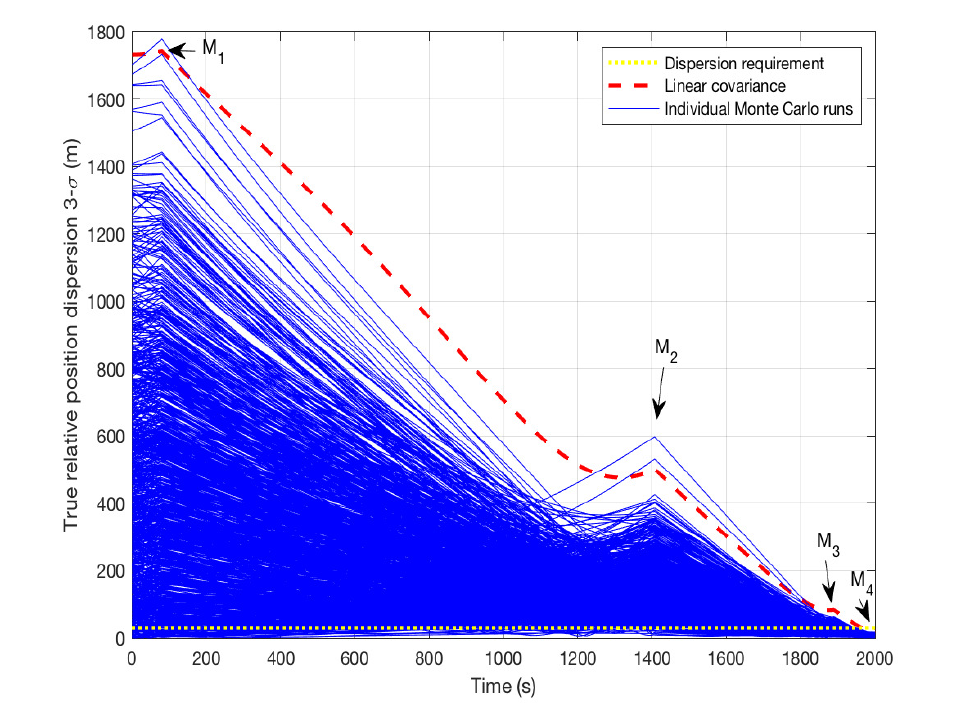
Figure 4. Monte Carlo analysis for low-cost system when t f = 2000